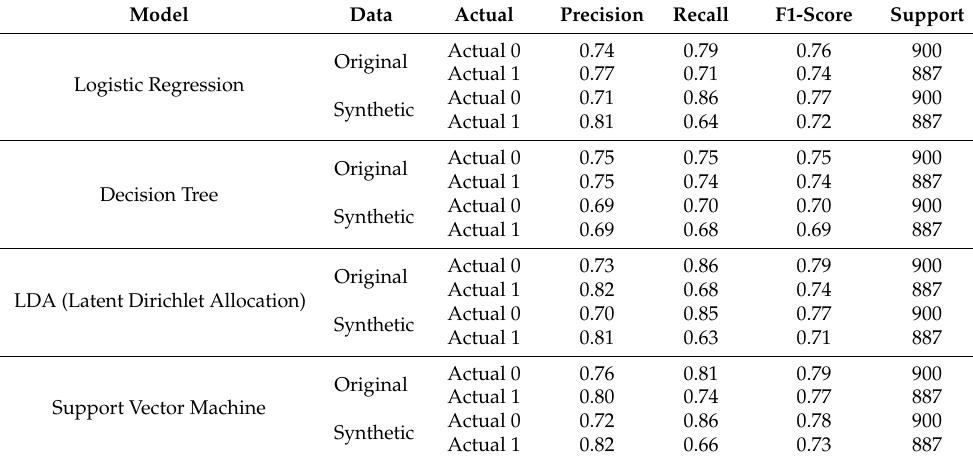
Table 5. Forecast accuracy